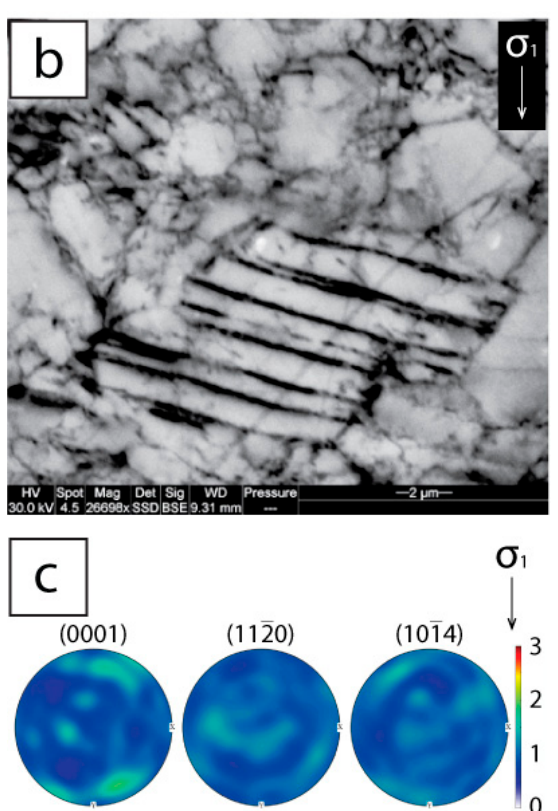
Figure 6. Microstructures in fine-grained magnesite cylinders deformed at T = 500 °C include flattened angular grains (arrows) and no twins or kinks ( a , SEM BSE image; MAG_005, T = 500 °C, P eff = 3.4 GPa, · ε = 2.7 × 10 − 5 s − 1 , σ diff = 1.6 GPa). Kinks (dark bands) are observed only in grains in the fine-grained magnesite cylinder deformed at P eff = 6.6 GPa ( b , SEM BSE image; MAG_004, T = 500 °C, P eff = 6.3 GPa, · ε = 2.7 × 10 − 5 s − 11 , σ diff = 3.1 GPa). The c-axes (equivalently poles to basal (0001) planes) form a weak point maxima parallel to the compression direction in the lower hemisphere equal area projection and a-axes (equivalently poles to (1120) planes) and poles to rhomb (10–14) planes do not show a clear pattern (c ; n = 780 ) .